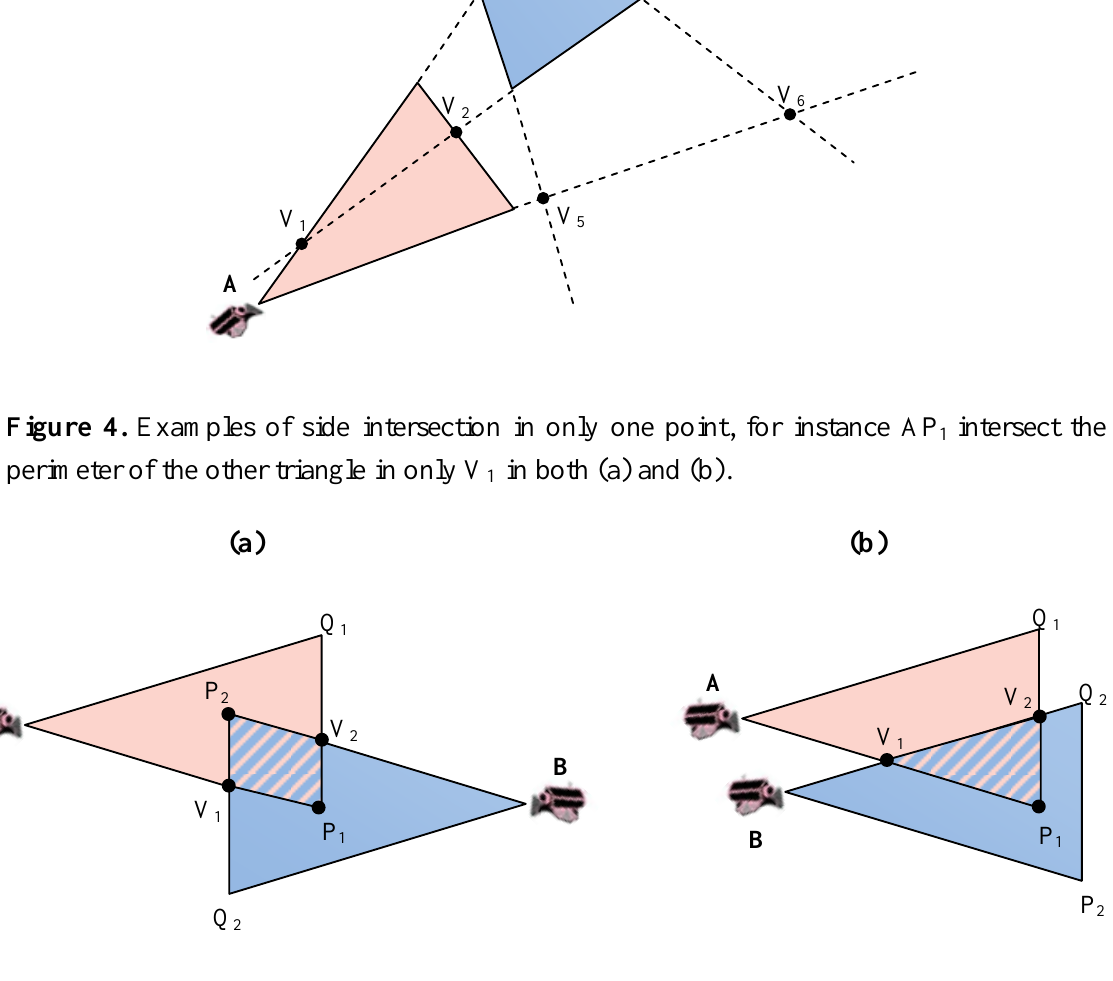
Figure 3. Non-acceptable intersection points, each two anti-parallel lines have an intersection point but the point have to satisfy Equation (8) to be a vertex of the intersection polygon.